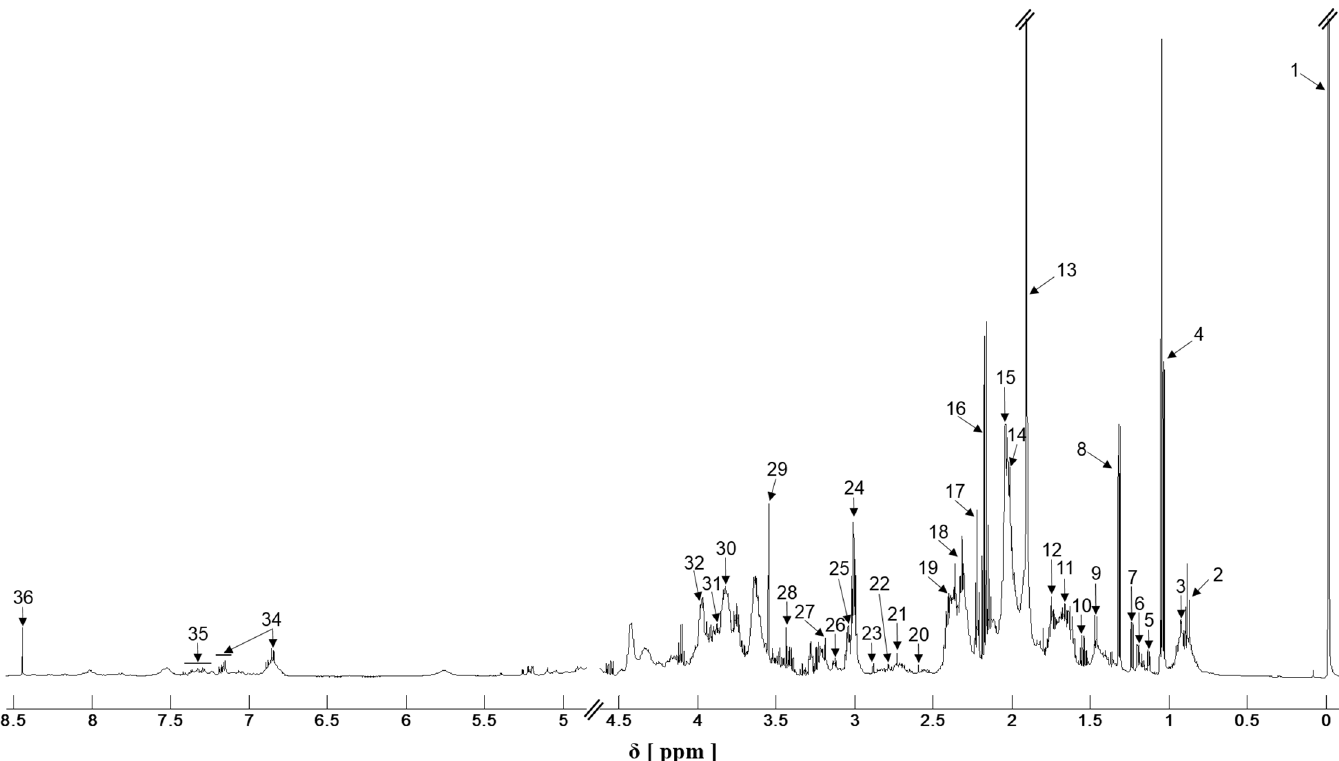
Fig 1. A typical H NMR spectrum of saliva. 1. TSP 2. Isocaprate+butyrate 3. Leucine+isoleucine 4. Propionate5. Propyleneglycol 6. Ethanol 7. Fucose 8. Lactate 9. Alanine10. Butyrate 11. 2-aminoadipate 12. Leucine13. Acetate 14. Proline15. Glutamate+isovalerate16. Propionate17. 2-aminoadipate 18.